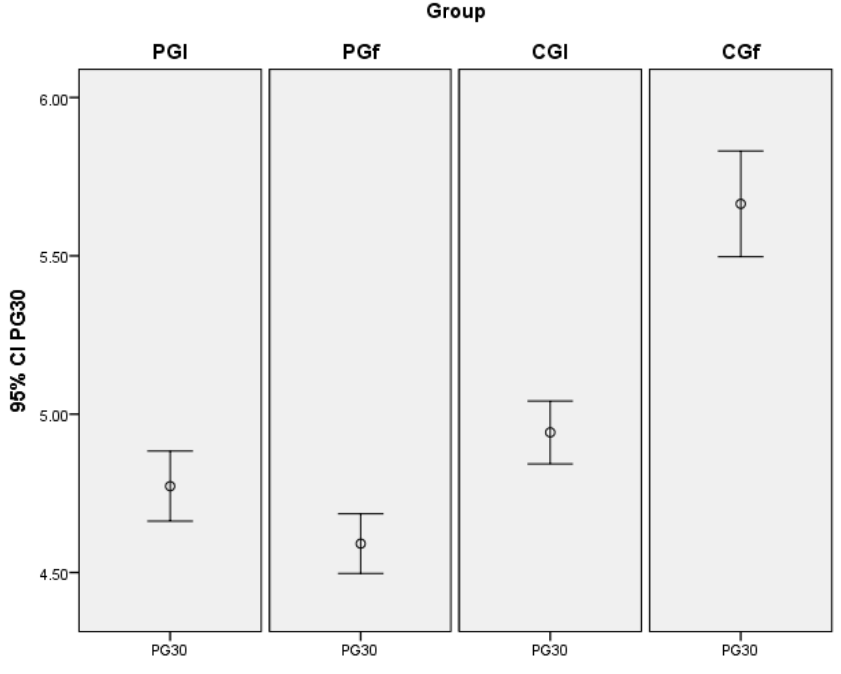
Figure 1. Speed 30 m means between the PG and CG group.